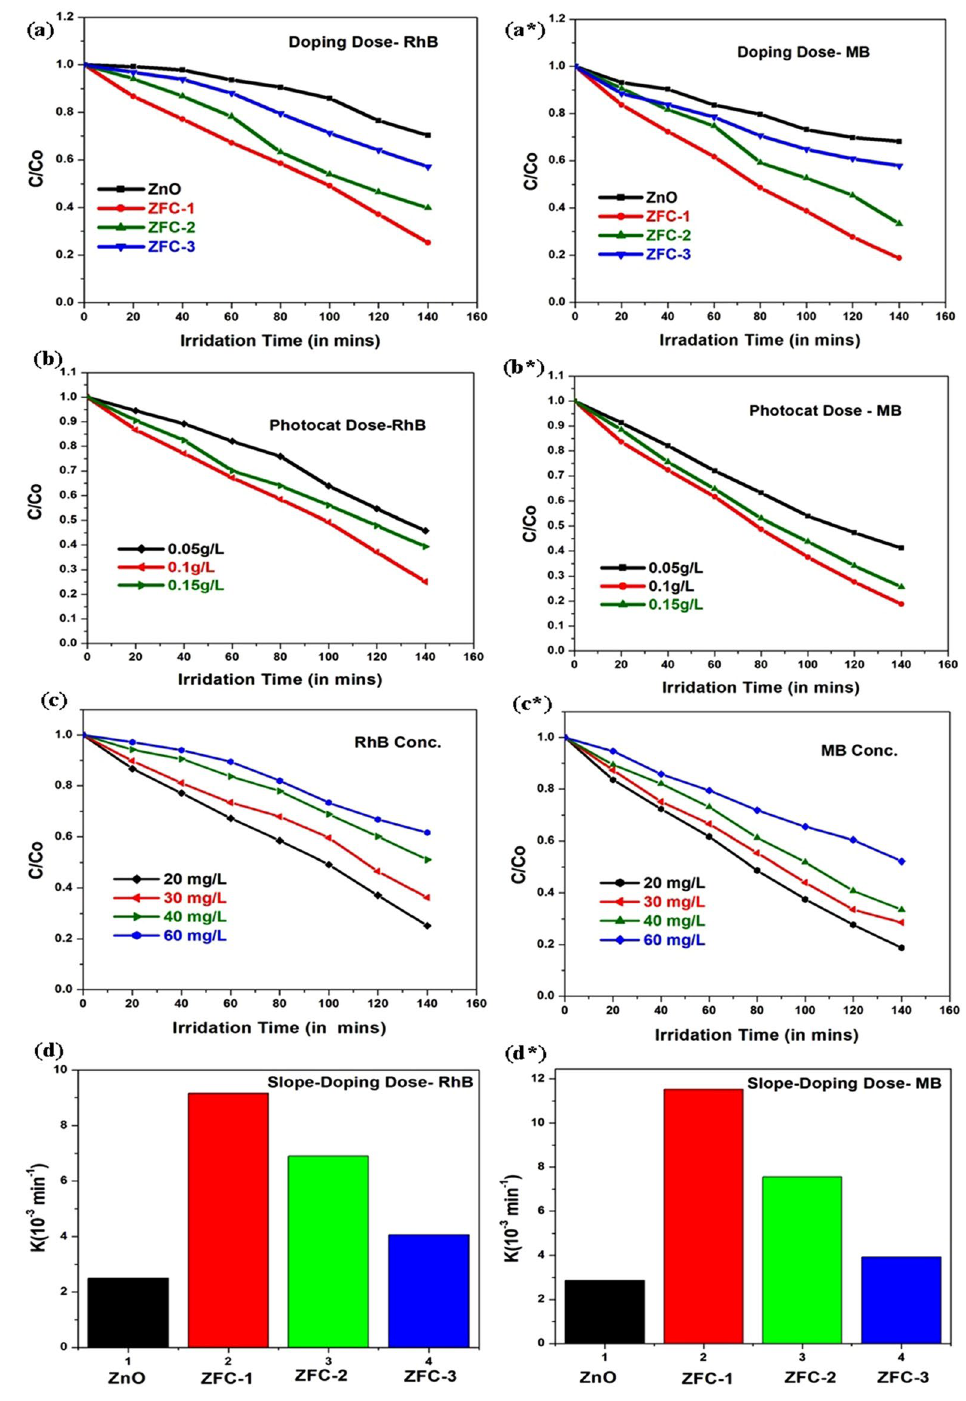
Figure 4. Influence on Photodegradation of RhB and MB aqueous solution with different ( a -a * ) doping concentration, ( b -b * ) photocatalysts mass, and ( c -c * ) dye concentration. ( d -d * ) degradation rate of